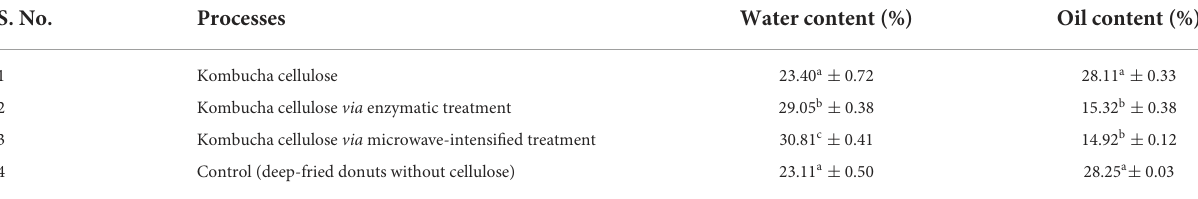
TABLE 2 Water and oil content of deep-fried donuts produced using various techniques. S. No.